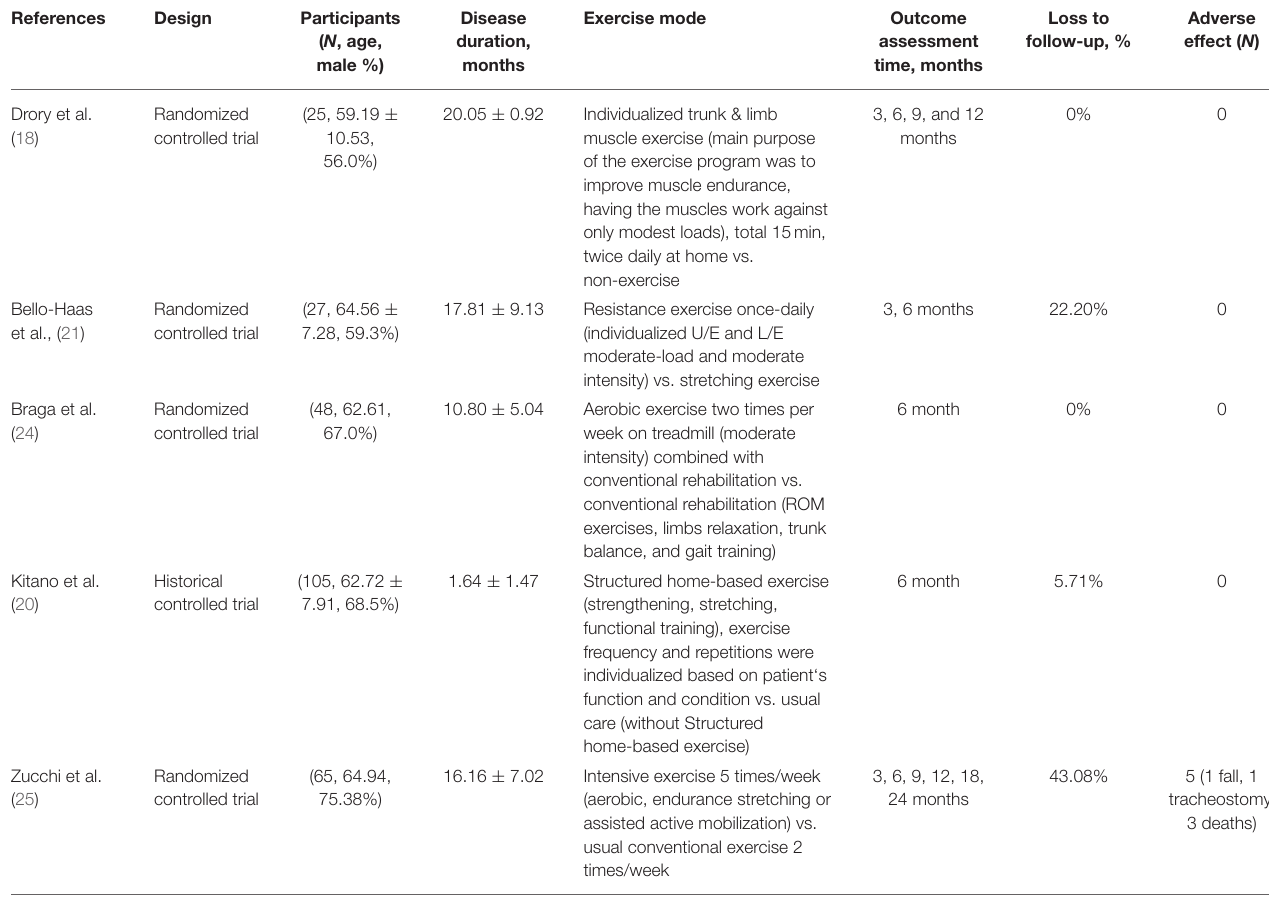
TABLE 1 | Characteristics of the included